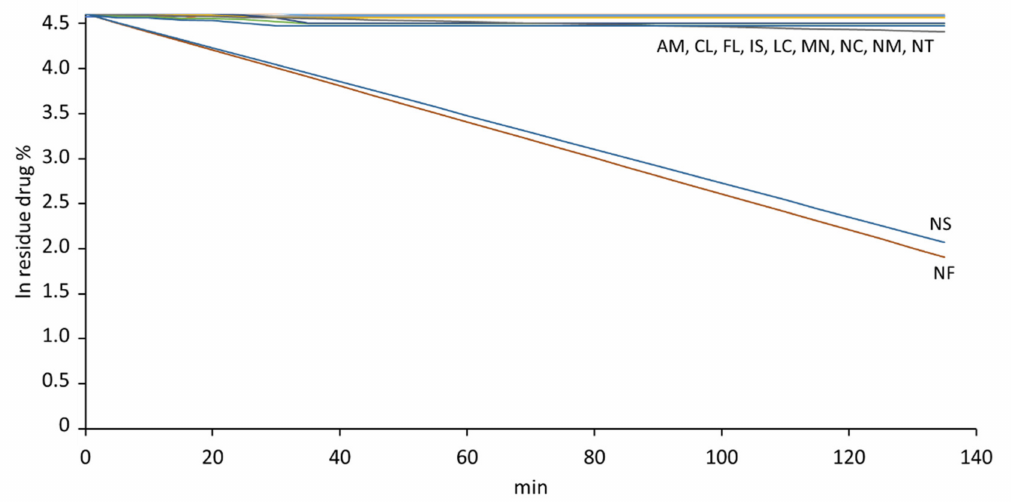
Figure 4. Kinetic curves resulting from degradation tests on hydroalcoholic DHP solutions in amber